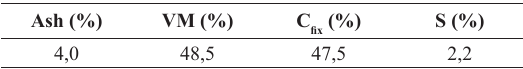
Table 3. Chemical composition of the tire rubber.